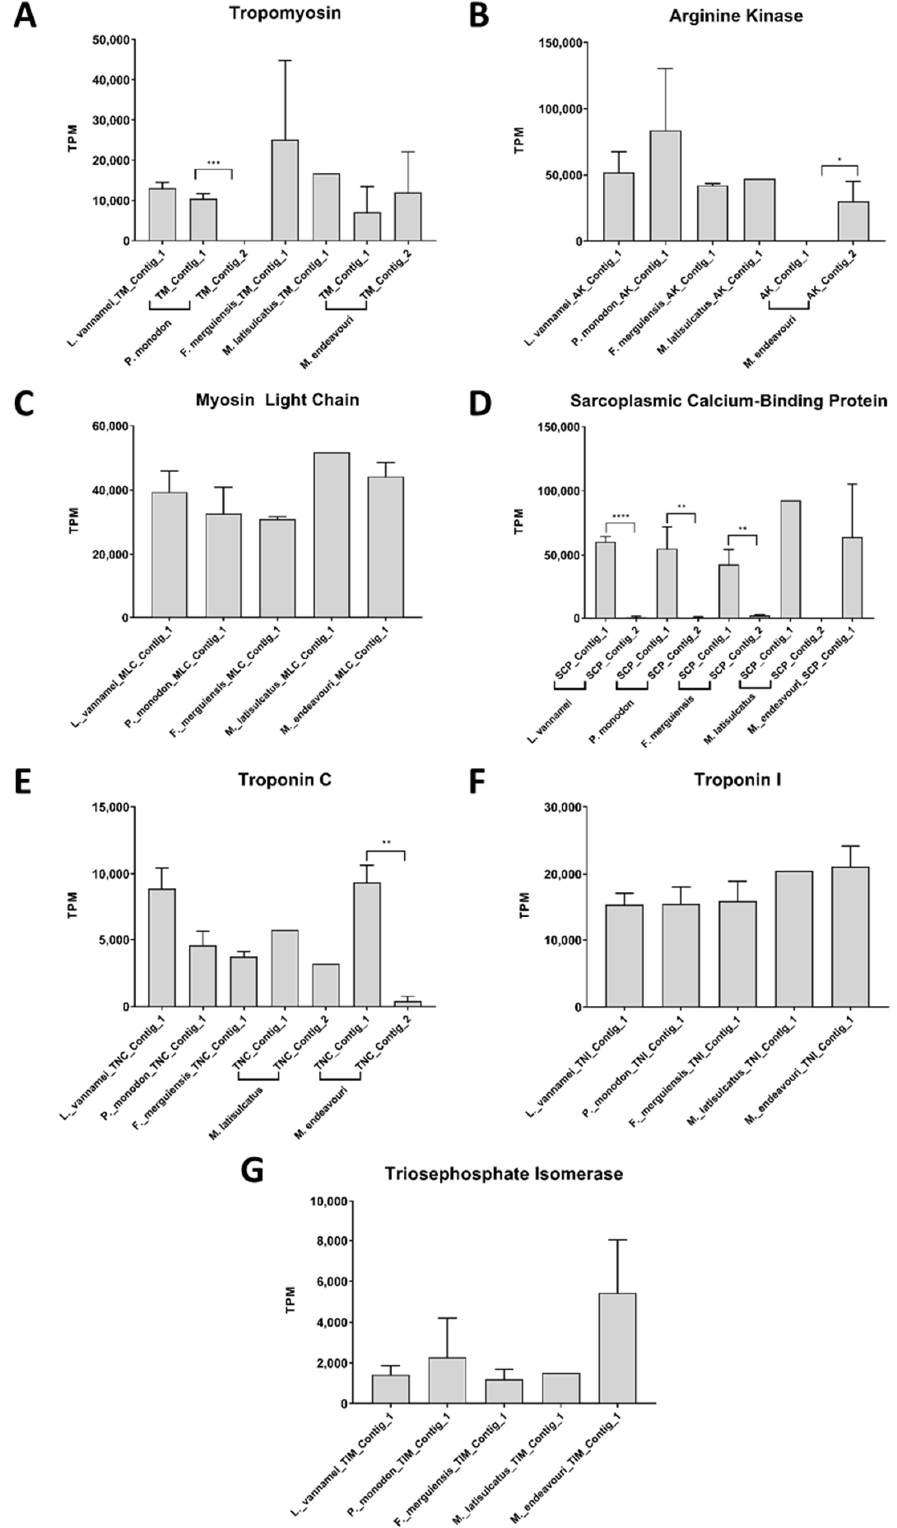
Figure 7. Abundance estimation values in transcript-per-million (TPM) for contigs in the 5 analysed shrimp species that matched with shrimp allergens. ( A ): tropomyosin, ( B ): arginine kinase, ( C ): myosin light chain, ( D ): sarcoplasmic calcium-binding protein, ( E ): troponin C, ( F ): troponin I, and ( G ): triosephophate isomerase. t -tests were employed to measure the significance of difference between two contigs from the same species, if present (*: p ≤ 0.05, **: p ≤ 0.01, ***: p ≤ 0.001, ****: p ≤